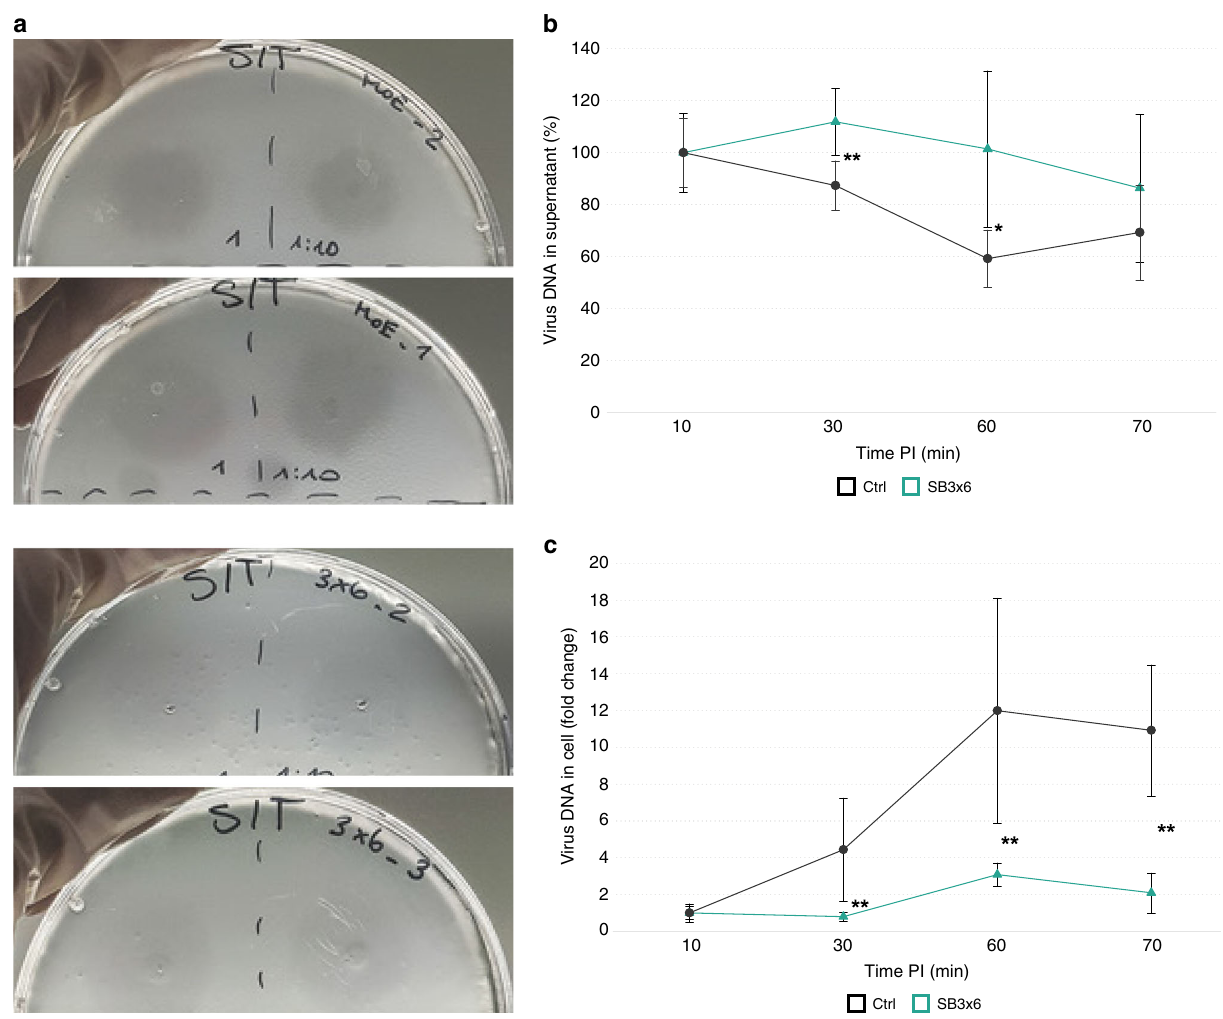
Fig. 7 Infection assays on slaB- silenced and control cultures. a Spotting assay using different dilutions of puri fi ed SSV1 virions on cells transformed with pIZ- Ctrl (upper panels) and pIZ-SB3×6 (lower panels), respectively. Two biological replicates presented (the same virion sample was used for the different overlays). b Relative amounts of extracellular virus DNA measured at certain timepoints postinfection (PI) in supernatants of pIZ-SB3×6 (petrol, triangle) and pIZ-Ctrl cultures (dark gray, circles), which have been challenged with SSV1 virions at MOI 0.1. Virus copies were determined by qPCR using D-291 FW/RV primers (Supplementary Table 1) and normalized to cell count in the individual samples and to the initial virus added. Percentage in relation to timepoint 10 min PI is shown. Error bars, mean ± SD (three biol. and techn. replicates). Asterisks indicate signi fi cant differences to Ctrl (two-tailed t test, n ≥ 3, p ≤ 0.0105). c Fold change of increase of virus DNA inside cells in same samples as in b . Virus DNA measurement was conducted as in b ; error bars are de fi ned as in b . Asterisks indicate signi fi cant differences to Ctrl (two-tailed t test, n ≥ 3, p ≤ 0.0083). Source data are provided